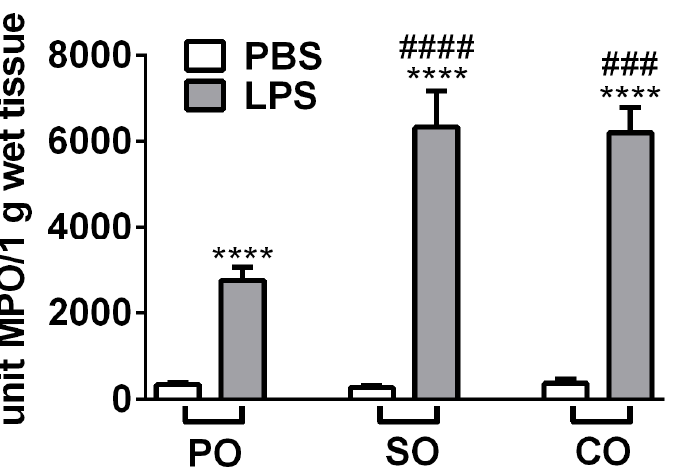
Figure 4. Myeloperoxidase (MPO) activity of the lung homogenates. Columns represent the means ± SEM of n = 6–8 mice/group (**** p < 0.0001 vs. respective PBS-treated group, ### p < 0.0005, #### p < 0.0001 vs. LPS-PO-treated mice; two-way ANOVA followed by Tukey post-test).